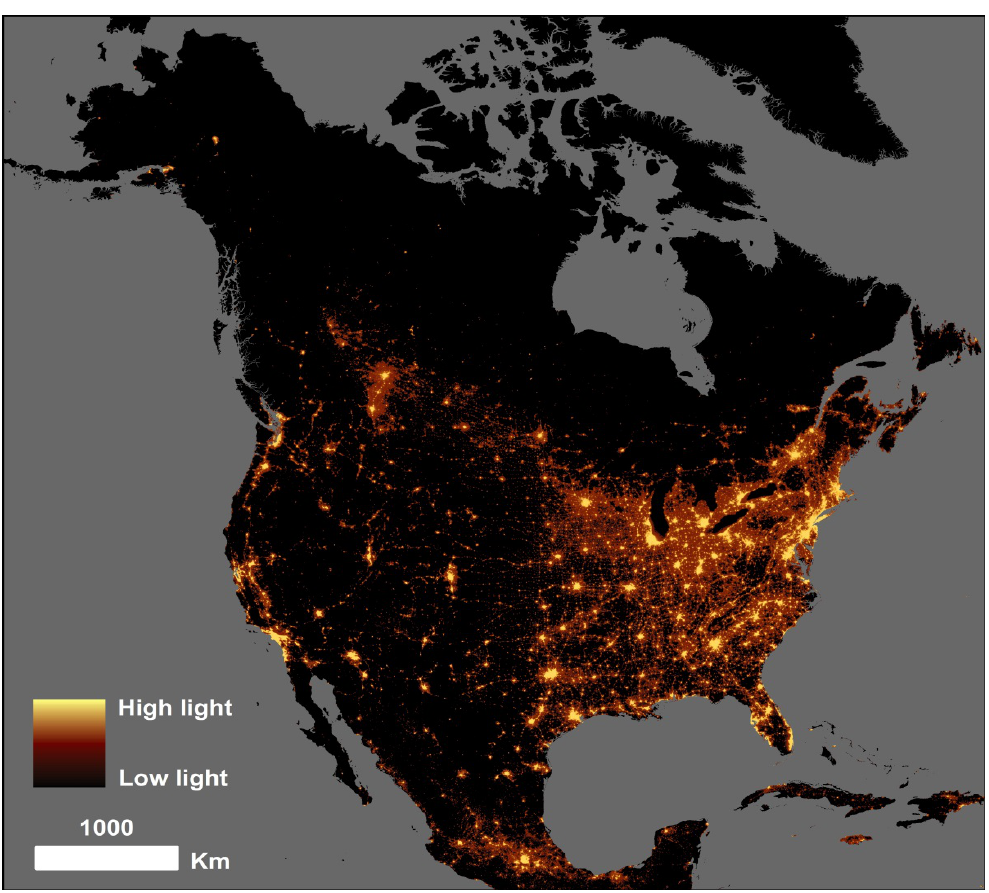
Figure 4. Nighttime light intensity for North America collected in 1996 and 1997 by the Operational Linescan System of the Earth-Observing Defense Meteorological Satellite